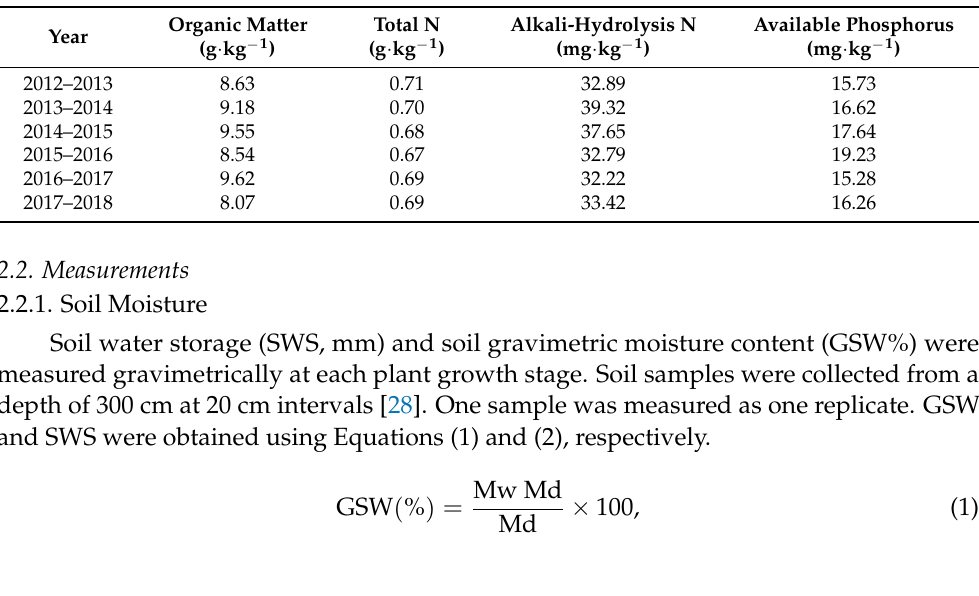
Figure 3. Illustration of sowing methods with row spacing (FS, furrow sowing; WS, wide-space sowing; DS, drill sowing), at different growth stages of wheat in the study area, Shanxi Wenxi, China. Each plot had an area of 300 m 2 (6 m × 50 m). Before planting, 150 kg N · ha − 1 (urea 46%), Table 1. During each cropping season, the planting density was 315 × 10 4 plants · ha − 1 . During each year, all plants were machine-harvested in late June. Throughout the growing season, weeds were manually controlled, and no irrigation was applied at any time during the entire experimental period. Table 1. Basic soil properties of the 0–20 cm layer in the study area from